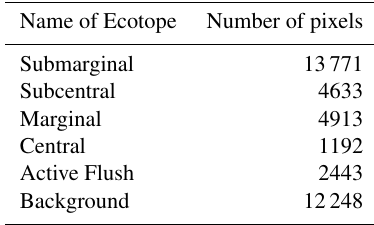
Table 2. Number of pixels per class –